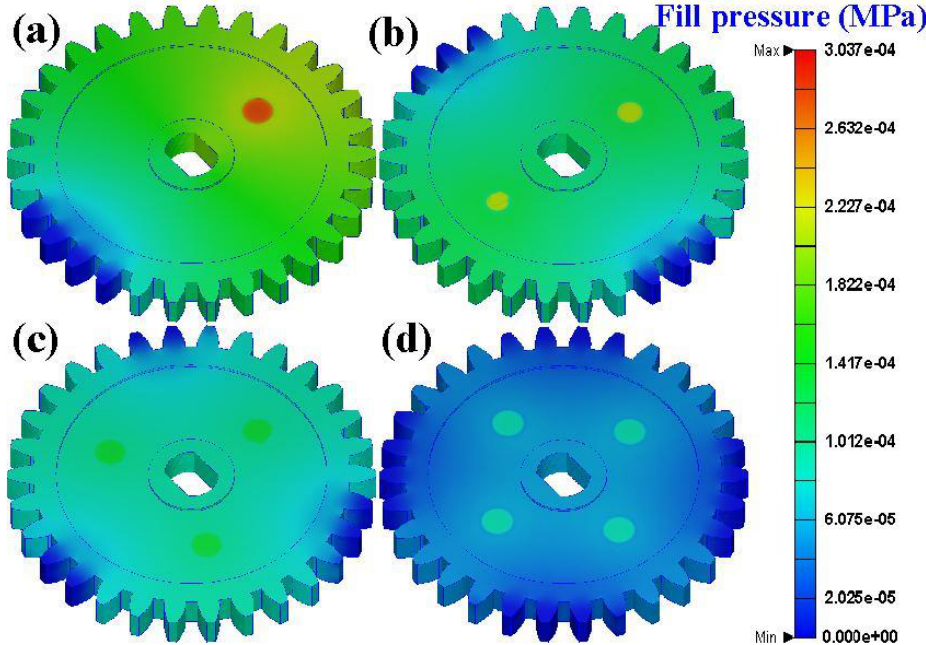
Figure 11. Filling maximum pressures for gate numbers of ( a ) single point, ( b ) two points, ( c ) three points, and ( d ) four points.